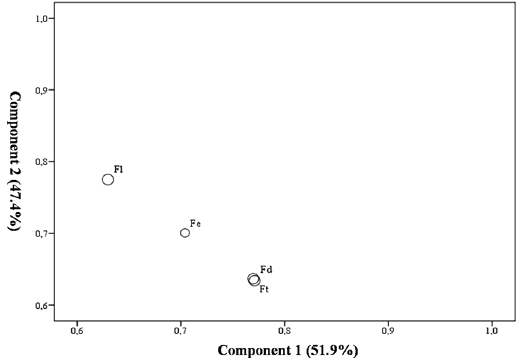
Figure 1. Scatter plot of buckwheat based on two discriminate components of PCA. The Ft represent F. tataricum , Fe represent F. esculentum , Fd represent F. dibotrys and the Fl represent F. luojishanense .